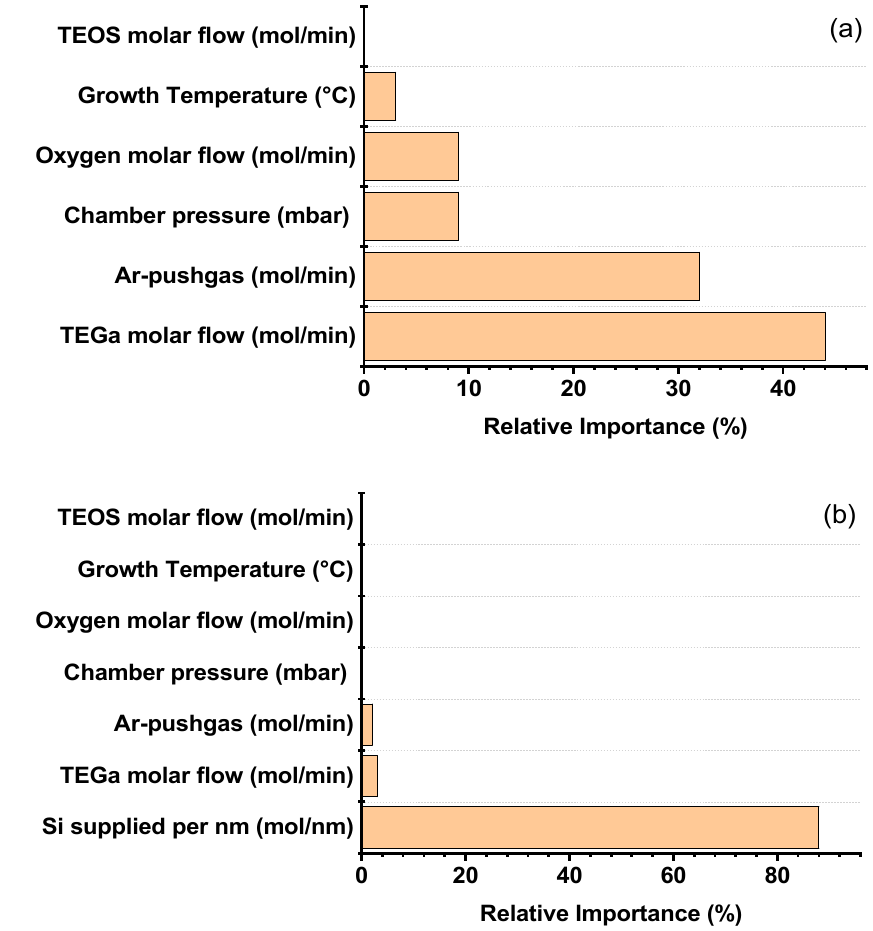
Figure 2. The parameter importance based on the trained fDNN model. The importance is ranked by the features containing the most information for the model to make a prediction of the free-carrier concentration in the films: ( a ) individual process parameters and ( b ) added with a created parameter: Si supplied per nm (mol/nm).